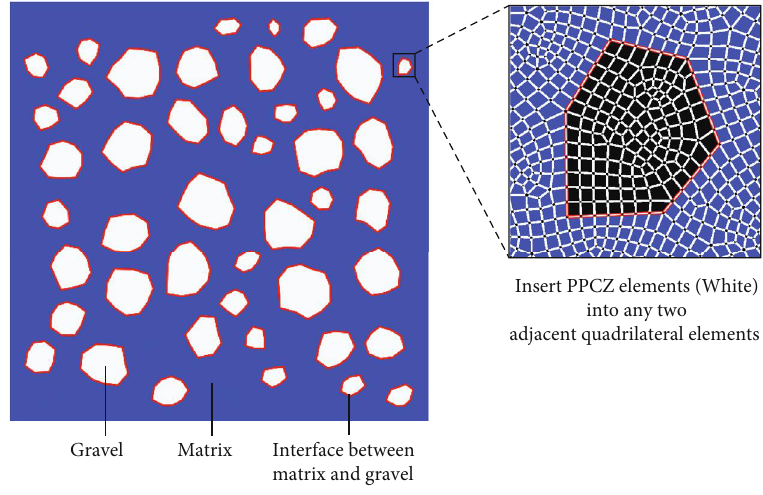
Figure 3: The GPPCZ Table 1: Experimental properties in the physical simulation and numerical validated model.